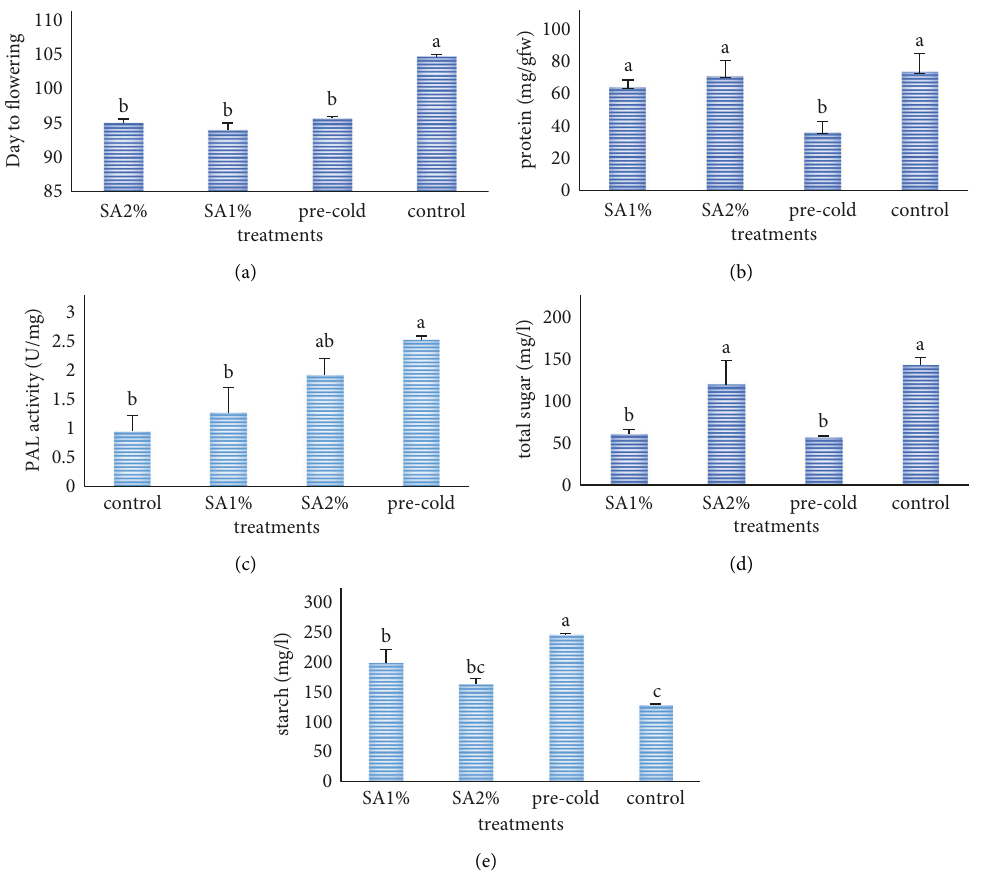
Figure 1: The effect of pre-cold and different levels of SA on (a) day to flowering; (b) corm total protein; (c) PAL activity; (d) com total soluble sugar content; (e) corm starch